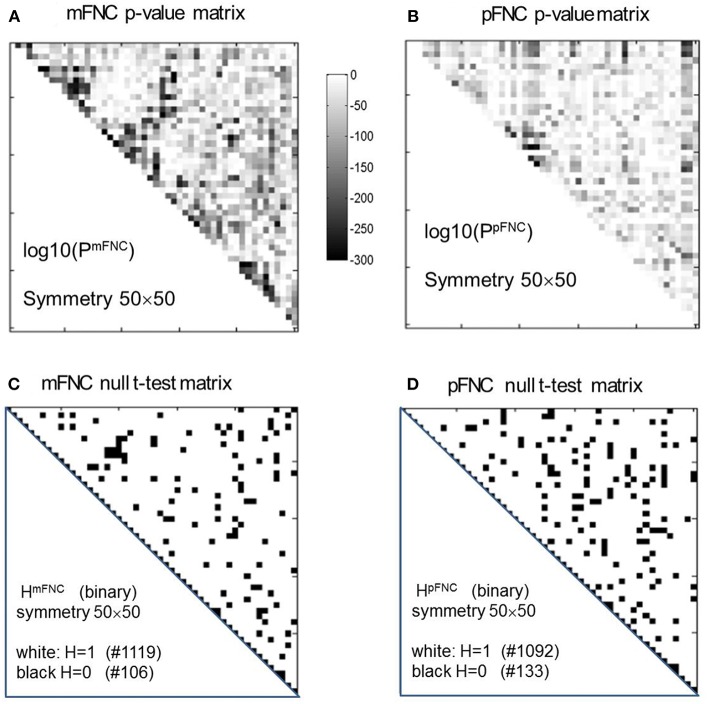
One-sample t-tests for the assemblies {mFNCn} and {pFNCn} (n = 1,2,…,600). (A,B) The t-test p-value matrices (displayed by a log10 magnification) using PmFNC(50,50) for {mFNCn} and PpFNC(50,50) for {pFNCn}; (C,D) The null-hypothesis test results (the entries with H = 1 were used for connection significance analysis).